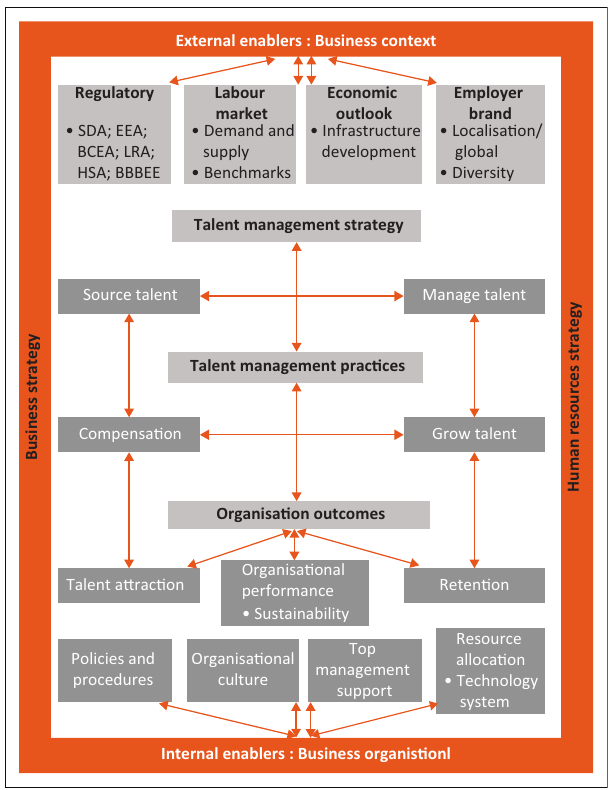
FIGURE 1: Talent management framework: attraction and